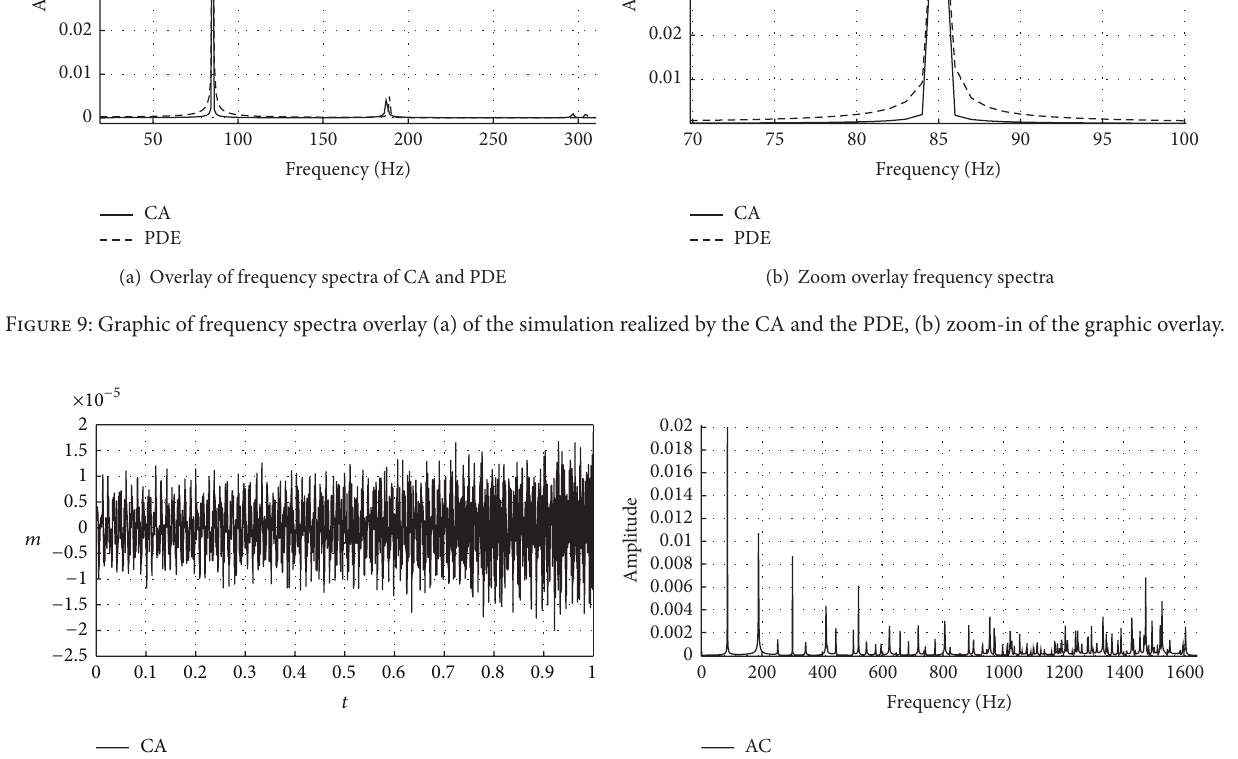
So, a fundamental frequency is expected approximately as = 84 . 1625 Hz 𝑓 1 , 1